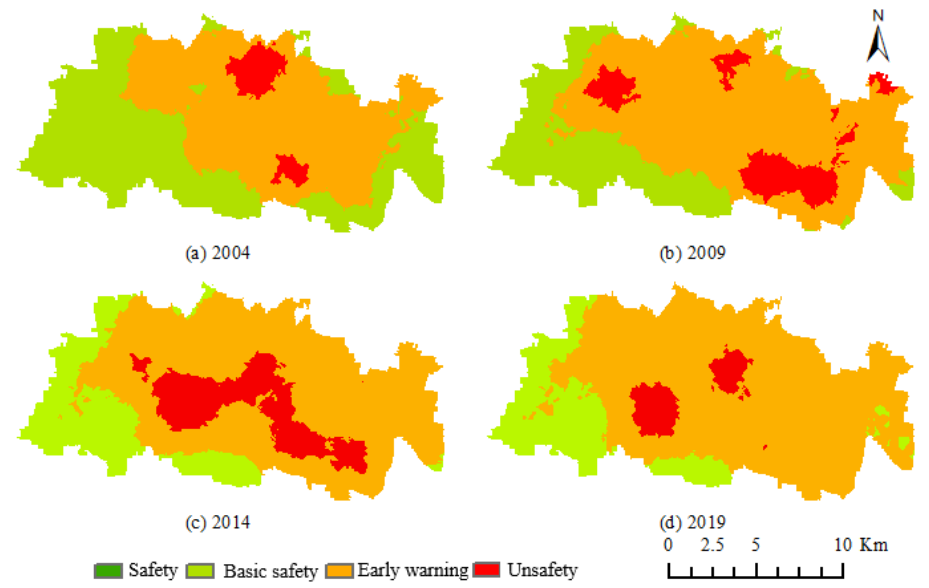
Figure 4. The gradation map of landscape ecological security of Zhaogu mining area during 2004–2019. Table 4. Area proportion and change rate of each landscape ecological security grade in Zhaogu mining area during